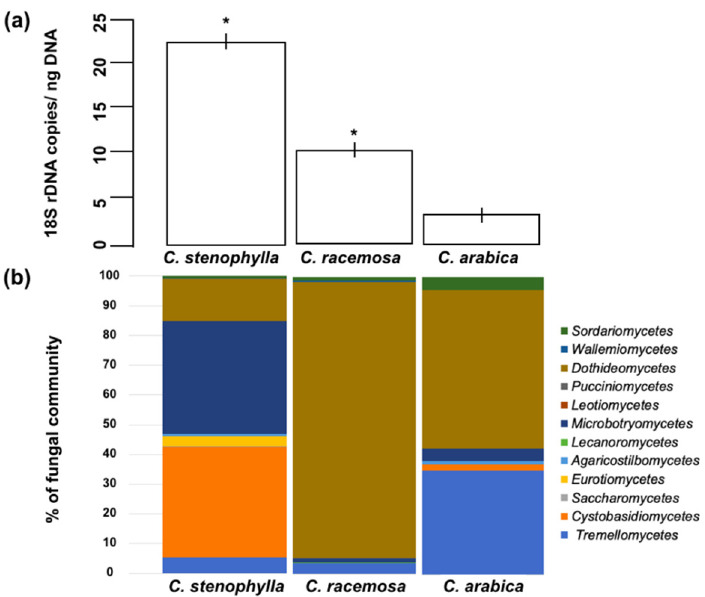
Figure 1. Fungal abundance and distribution in the phyllosphere of Coffea . ( a ) Total fungal abun- dance in the phyllosphere by the number of 18S rRNA copies per nanogram of total DNA. * Signif- icant difference when comparing with C. arabica ( p < 0.05). ( b ) Fungal distribution in the phyllo- sphere at the “class” level.